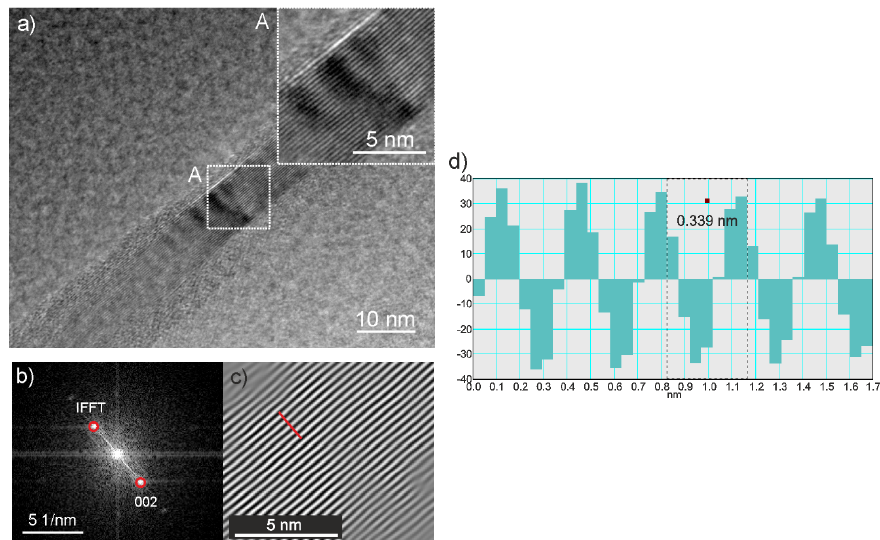
Figure 1. Transmission electron microscopy ( TEM) micrograph ( a ) and selected area electron diffraction (SAED) pattern of the area marked as A in Figure 1a with identification ( b ), as well as the X-ray diffraction (XRD) pattern ( c ) of graphite particles consisting of graphene layers stacked together.